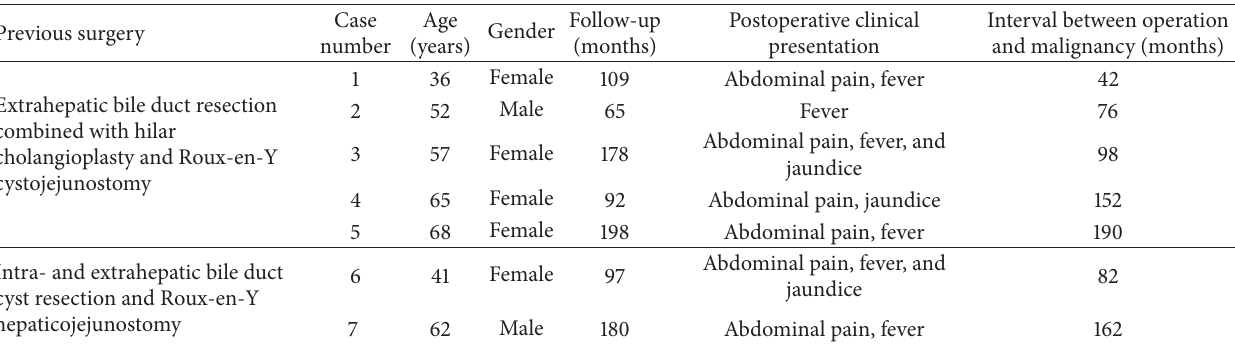
Table 2: Demographic and clinical data of seven patients treated at our hospital who developed postoperative malignancy. Previous